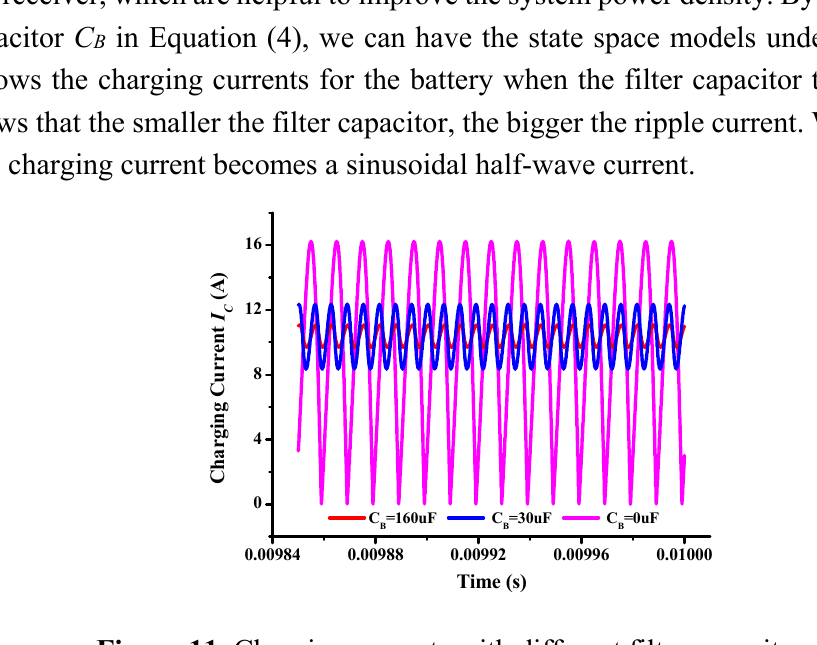
Figure 11. Charging currents with different filter capacitors.